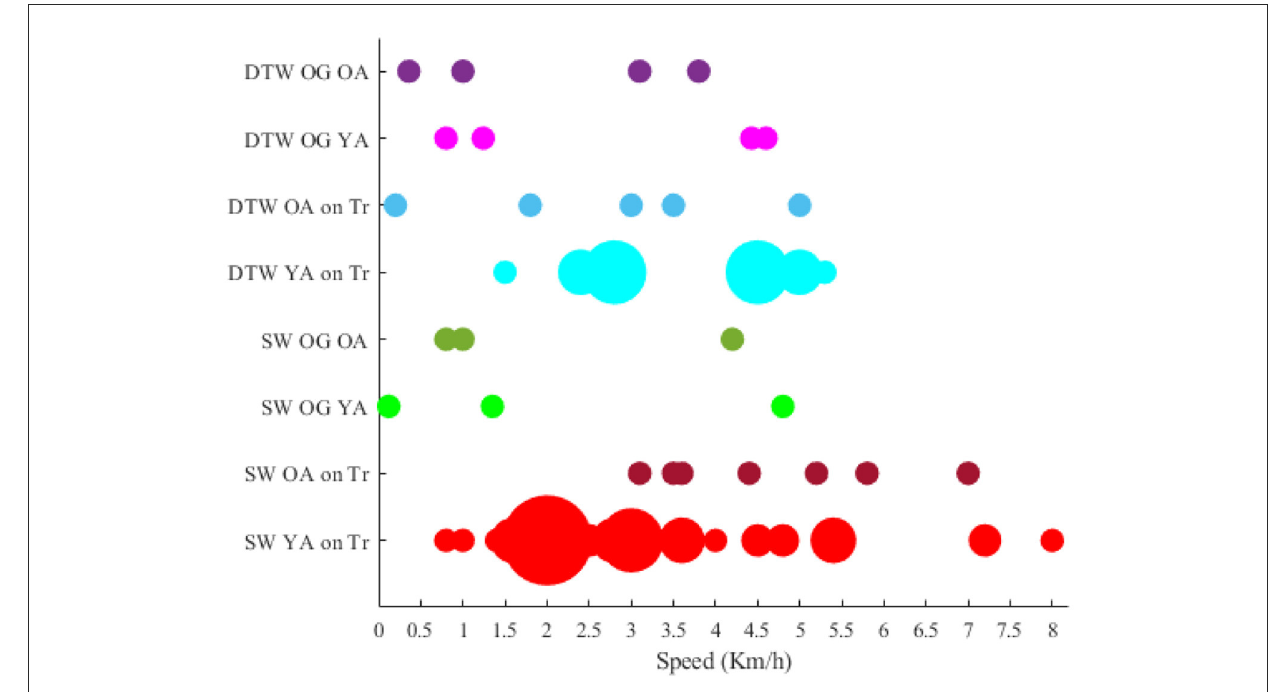
FIGURE5 Intensity of locomotion in existing experiment